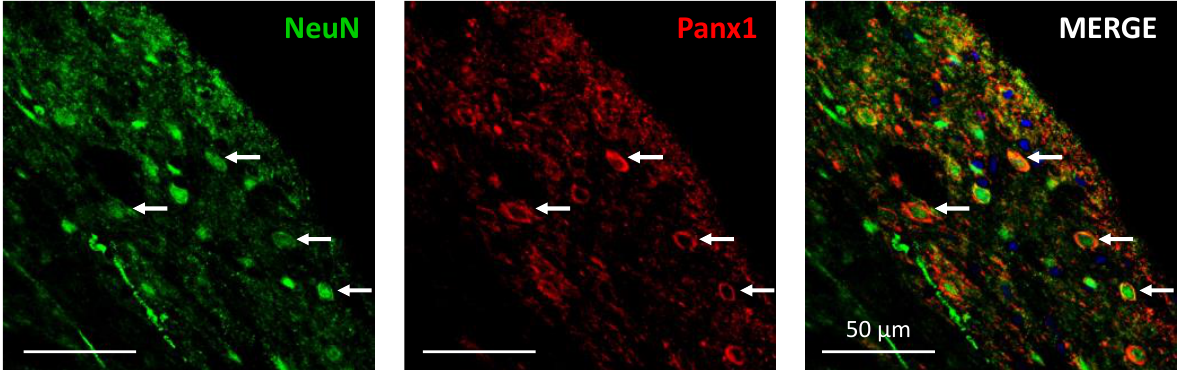
Figure 5. Confocal images from a 200µm-thick lumbar spinal cord transverse slice of a neuropathic rat, showing some selected neurons from Rexed laminae I and II (see white arrows) labeled with NeuN immunofluorescence ( left panel ), Panx1 immunofluorescence ( middle panel ), and double Neun/Panx1 immunofluorescence ( right panel ). Panx1 channel expression was often visualized surrounding neuronal nuclei colabeled with the NeuN protein, thus indicating the presence of Panx1 in intrinsic dorsal horn neurons. Blue labeling in the right panel corresponds to DAPI fluorescent nuclear stain. Scale bars: 50 µm in all three panels.